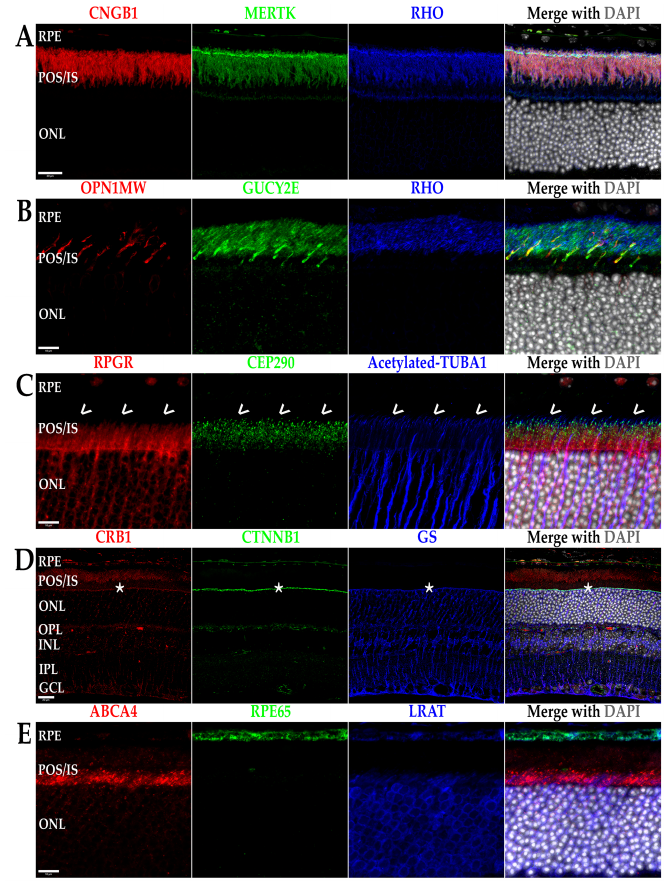
Figure 1. Immunohistochemical localization of many common inherited retinal dystrophy (IRD)- associated proteins. ( A , B ) Outer segment (POS) localization of phototransduction proteins